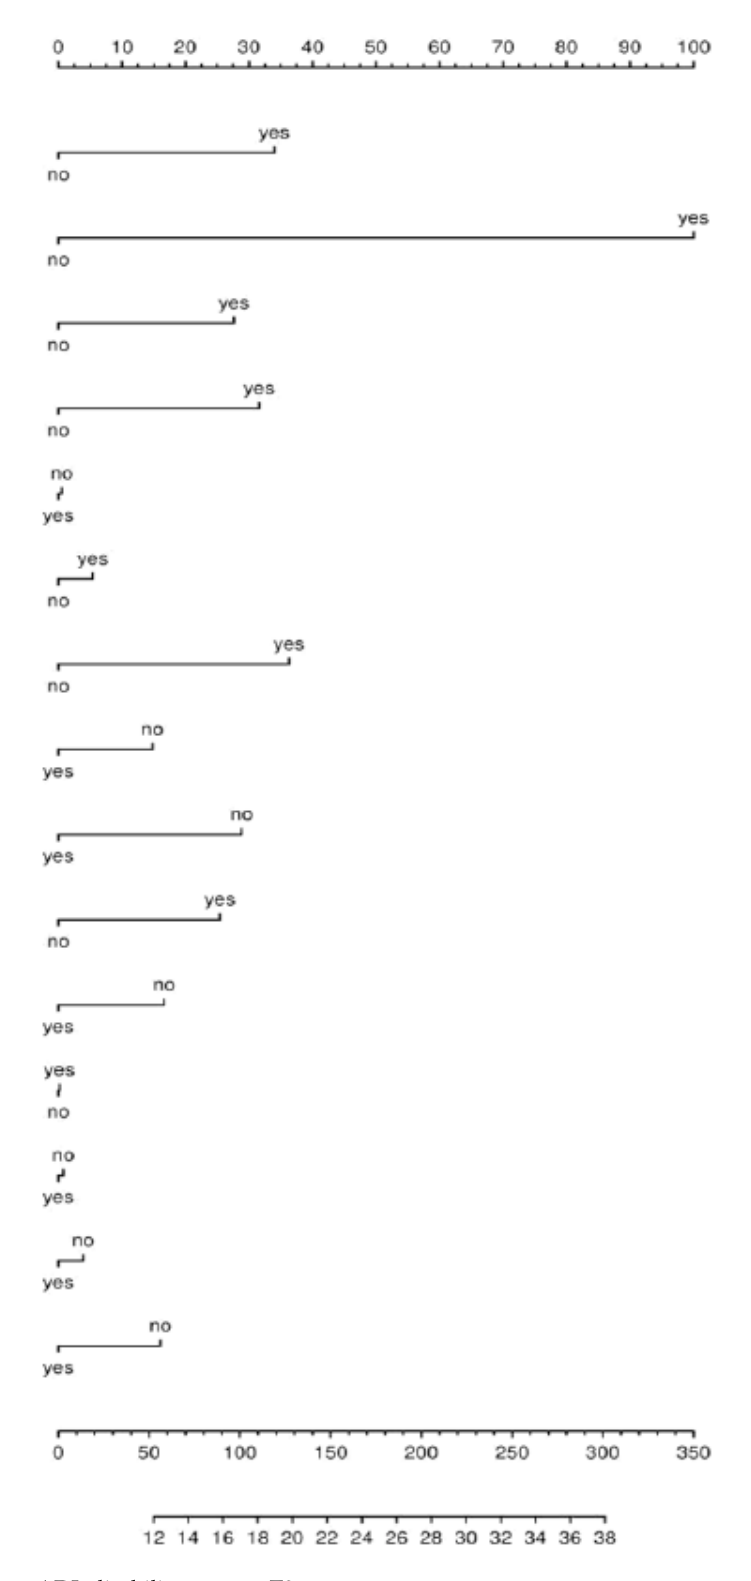
Figure A6. Nomogram ADL disability score at Figure 6. Nomogram ADL disability score at T9. Table 5. Rsq-values and relative importance TFI items for the ADL disability scores.